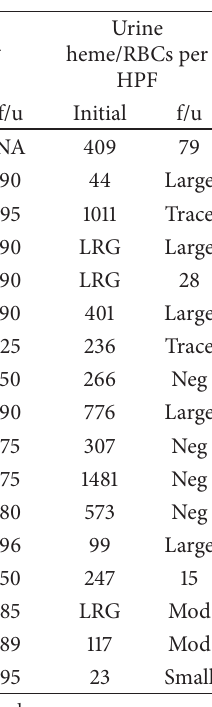
Table 2: BP and urine findings during acute PSGN and at